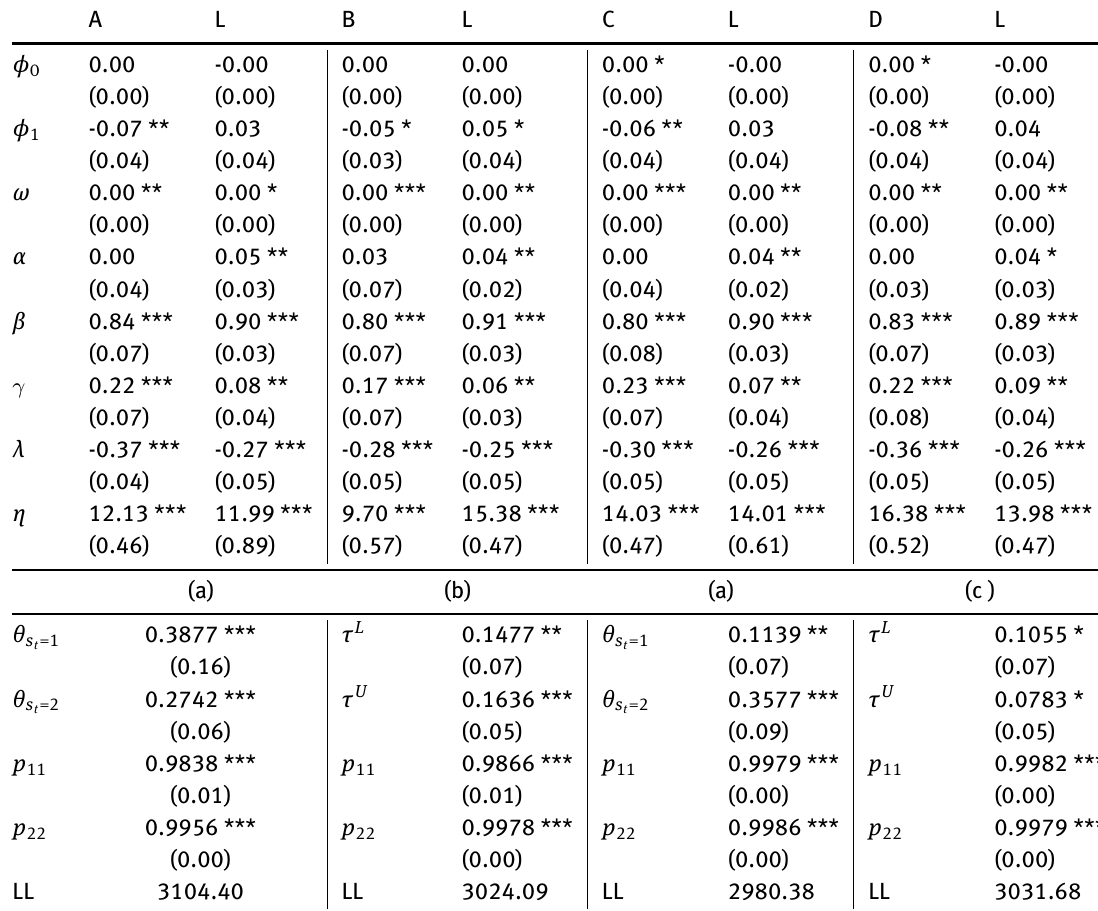
Table 8a: Parameter estimates for the joint distribution using a mixture of copulas where the weights are given by the forecast probability of each